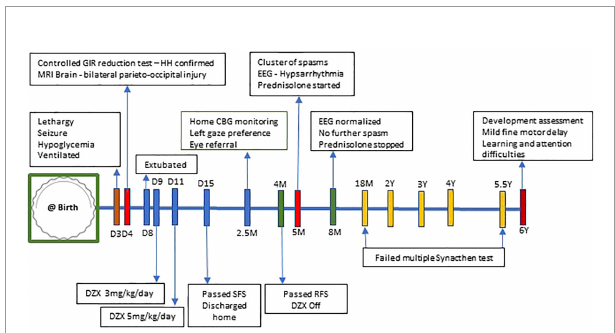
FIGURE 4 | Timeline of events from day 3 of life to 6 years of age. CBG, capillary blood glucose; DZX, diazoxide; GIR, glucose infusion rate; HH, hyperinsulinemic hypoglycemia; RFS, resolution fast study; SFS, safety fast study; D, day of life; M, months; Y, years.